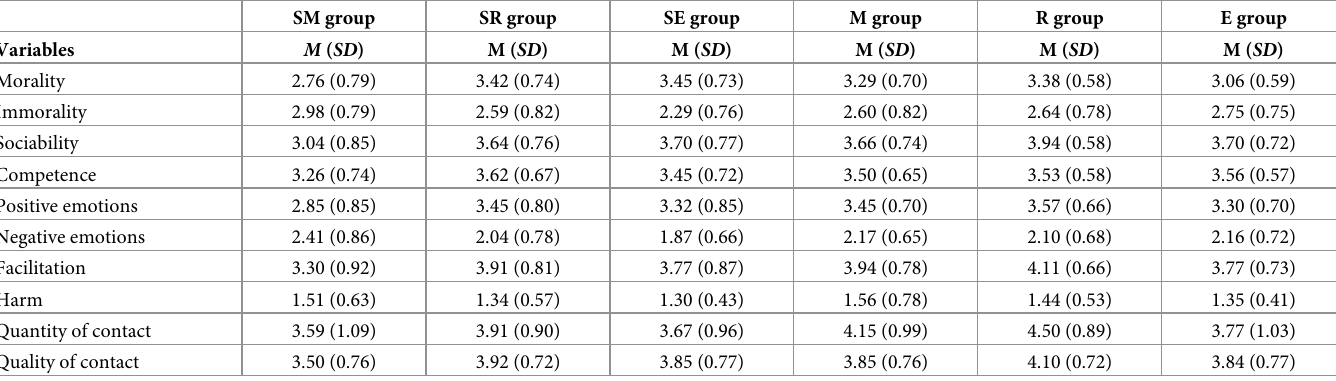
Table 2. Descriptive statistics of all the variables in the six